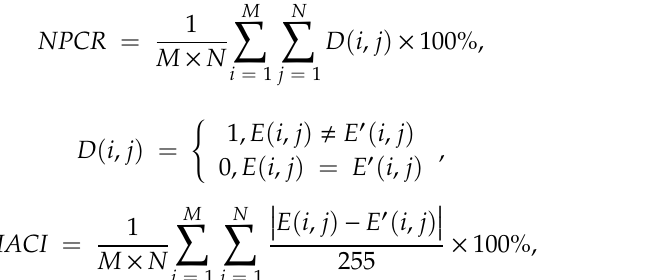
Figure 11. CC values change along with the iteration number.